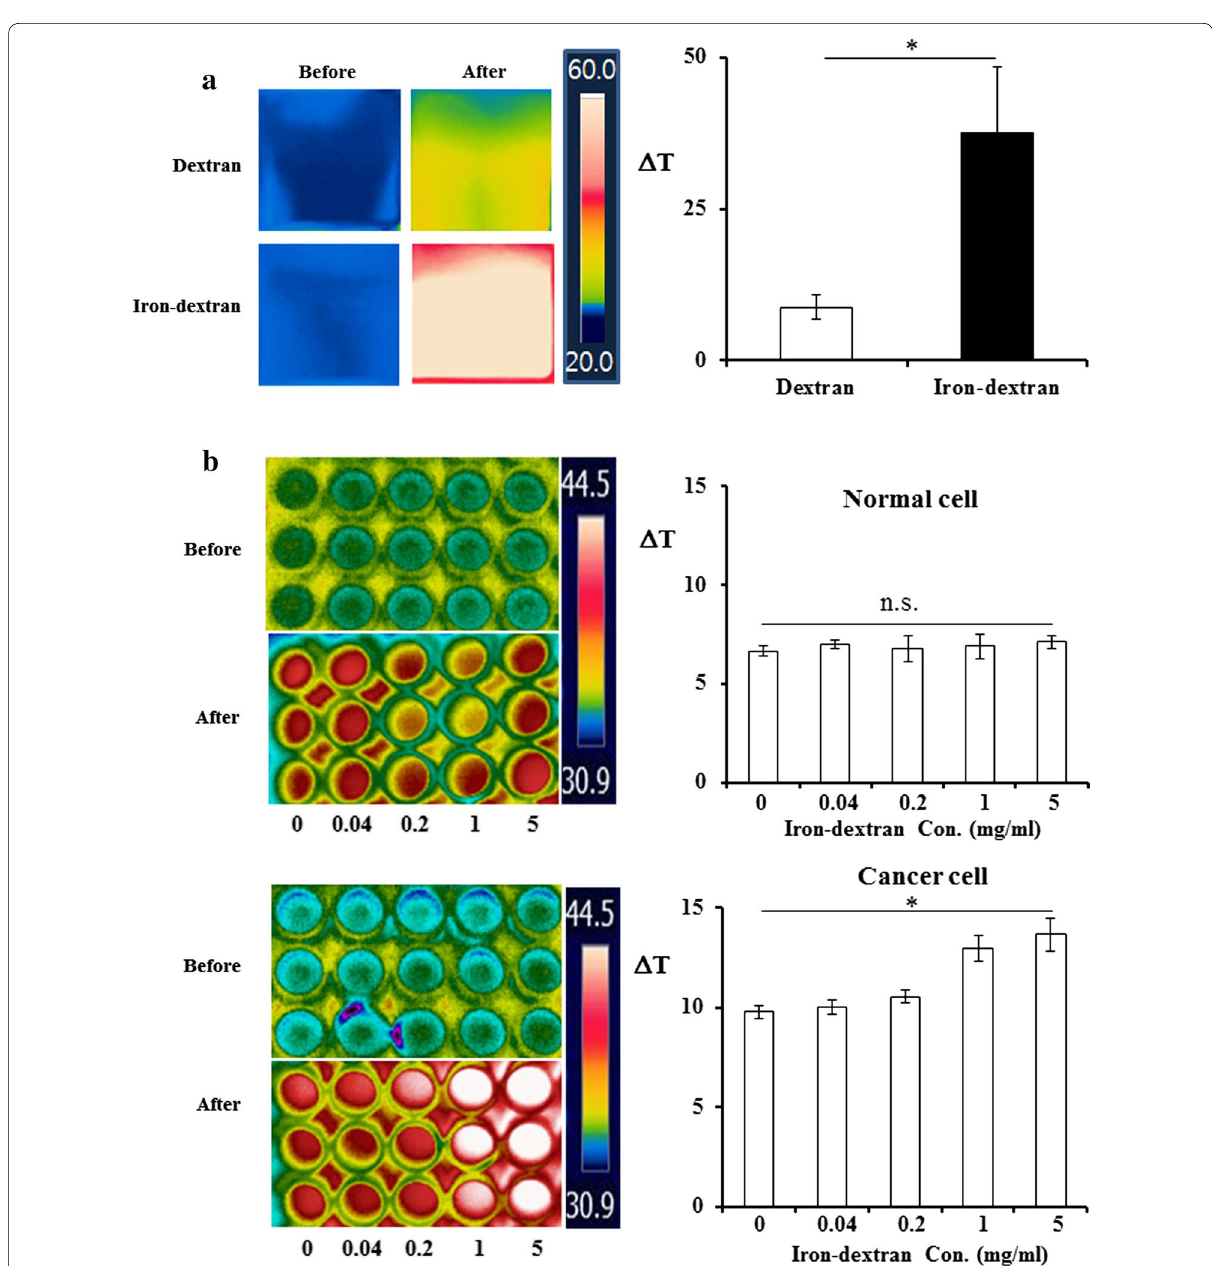
Fig. 1 Iron‑dextran induced dielectric heat in the 13.56 MHz RF wave to boost temperature elevation. a The iron‑dextran generated heating upon RF hyperthermia and the temperature was elevated significantly compared to iron‑free dextran solution. b Exposure of human lung cancer NCI‑H460 cells to iron‑dextran boosted temperature elevation in a dose‑dependent manner while this effect was not observed in normal cells. The values represent the mean SD (n 6). A paired Student’s t‑test was used for the statistical analysis; * p < ± =